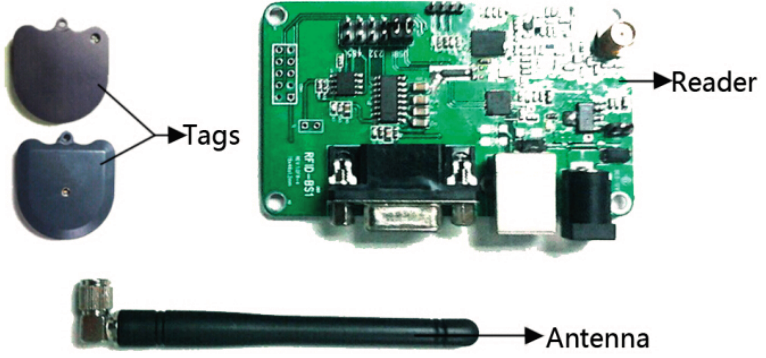
Figure 4. RFID hardware devices for the vehicle positioning experiment.